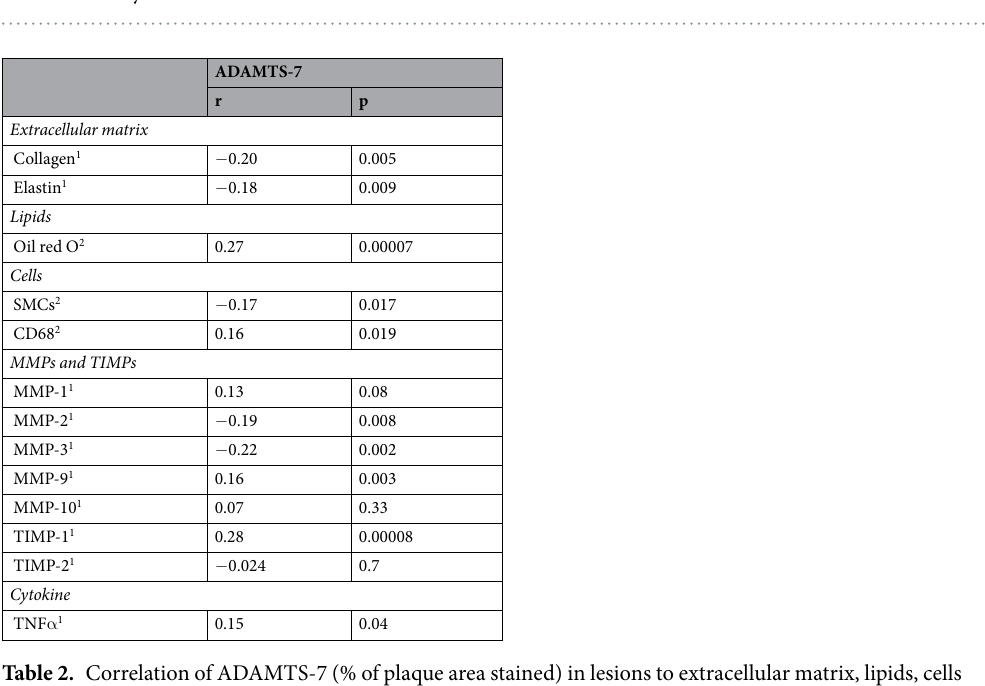
Figure 1. ADAMTS-7 is increased in symptomatic and vulnerable lesions. ADAMTS-7 (% of plaque area stained) is increased in carotid lesions removed by endarterectomy from symptomatic patients compared to lesions from asymptomatic patients ( a ). ADAMTS-7 is increased in lesions with a high vulnerability index (above median) ( b ). Vulnerability index was calculated based on lipid-, CD68-, hemorrhage-, SMC-, and collagen-staining (% of plaque areas stained). Values are presented as boxplots. Number of plaques = 206; Mann-Whitney test.